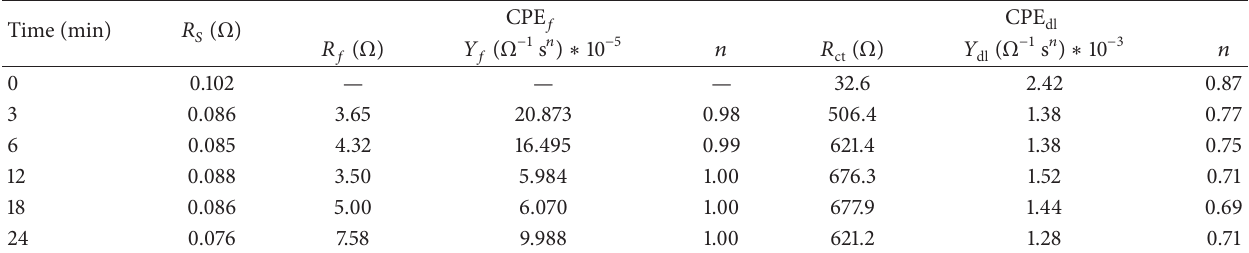
Table 5: Equivalent circuit parameters for effect of the addition of CO